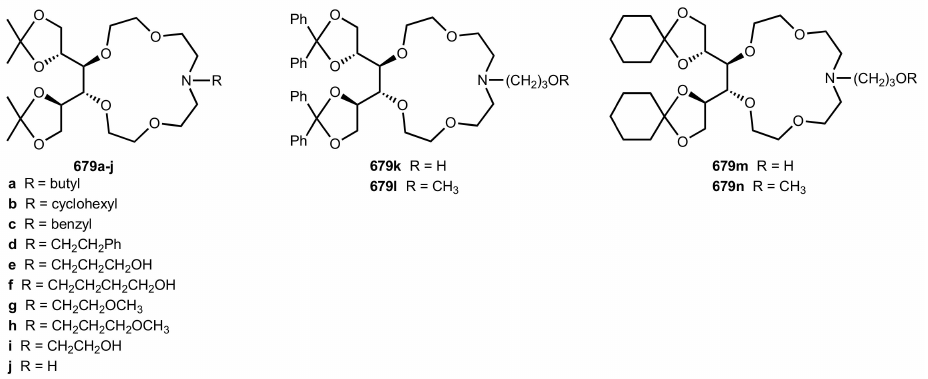
Figure 44. Series of prepared mannitol-based aza-crown